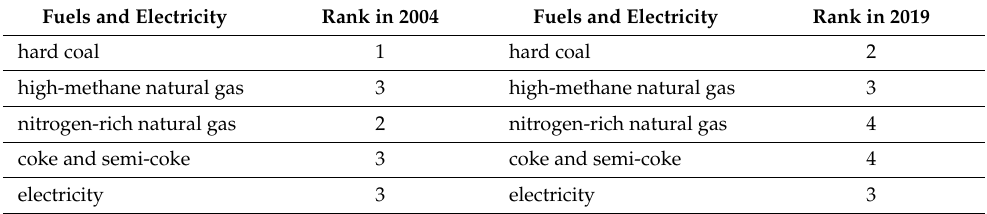
Table 4. Position of the food industry in terms of fuel and electricity consumption in 2004 and